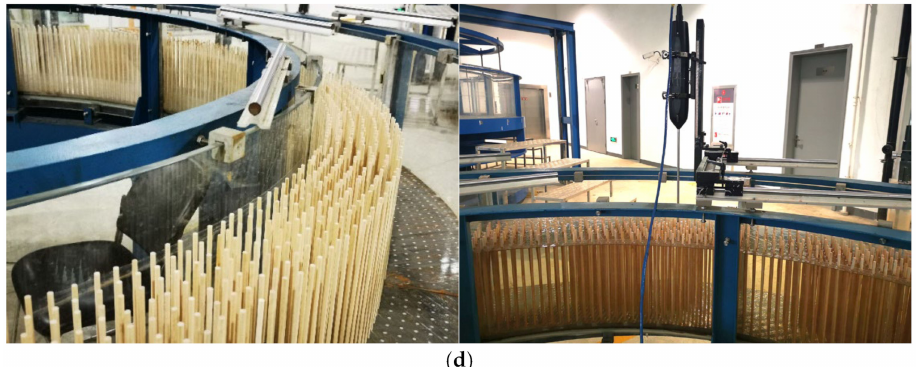
Figure 1. Vegetation configurations for laboratory experiments (Left: top view; Right: cross-section view, h is water depth, B is the channel width, Bv is the width of vegetation patches, and Bv/B is 1/2 in our experiments). ( a ) Bare-bed case. ( b ) Convex case ( c ) Concave case ( d ) Photos of vegetation configurations (taking the convex case as an example).